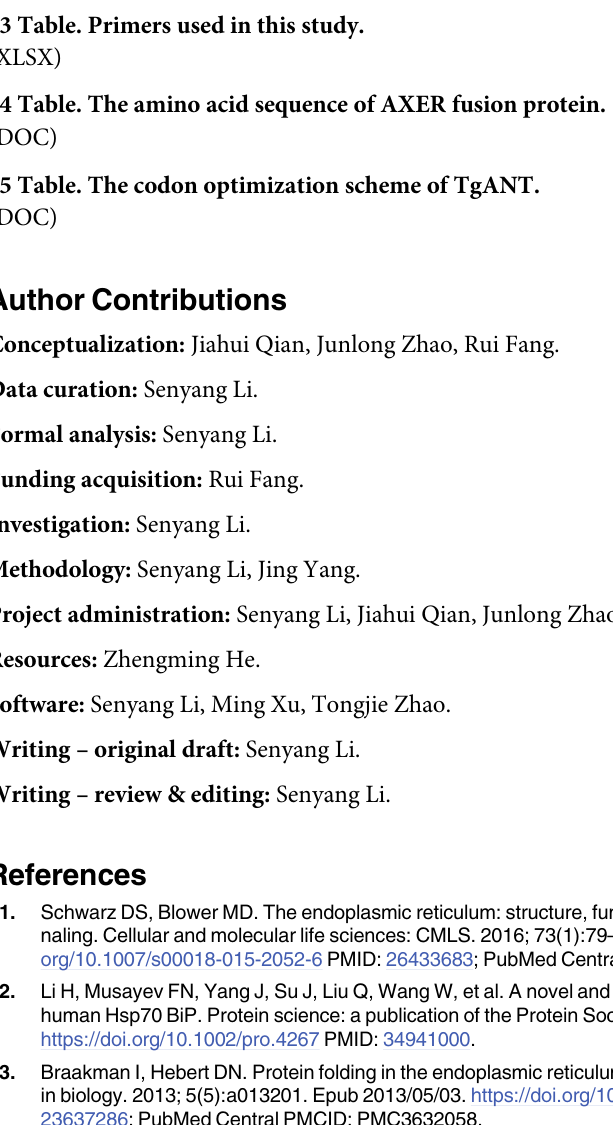
S2 Fig. The Phenotypic experiment of heterologous supplementation strains. (A) IFA con- firmed the correct integration and expression in ER of iTgANT::hUGT2 strain. (B) and (C) Intracellular replication assay(B) and plaque assay(C) comparing the growth of TgANT deple- tion strain and hUGT2 complementation strain. Means ± s.e.m. ��� p � 0.001, two-way ANOVA, three independent repeated, a representative one is shown here. S1 Table. Potential transporters screened out from ToxoDB . In order to narrow the screen- ing range, we set the transmembrane domain greater than 6 ( � 6), and the CRISPR phenotype value less than -3 ( � -3) as our screening threshold. S2 Table. Strains and plasmids used in this study. S3 Table. Primers used in this study. S4 Table. The amino acid sequence of AXER fusion protein. S5 Table. The codon optimization scheme of